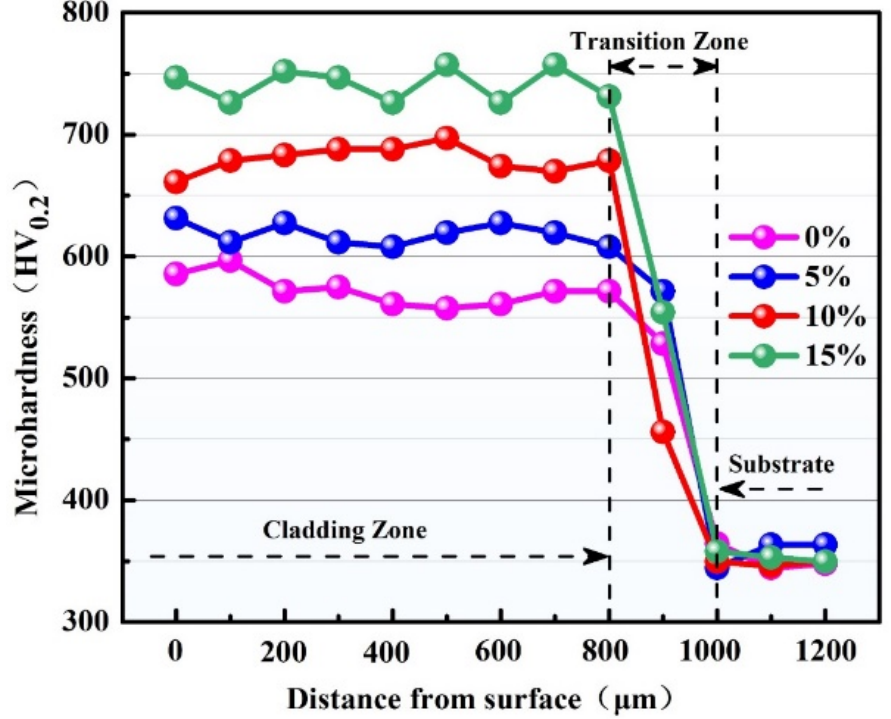
Figure 8. Microhardness distribution along the depth direction of a cross-section of the TiAl composite coating.